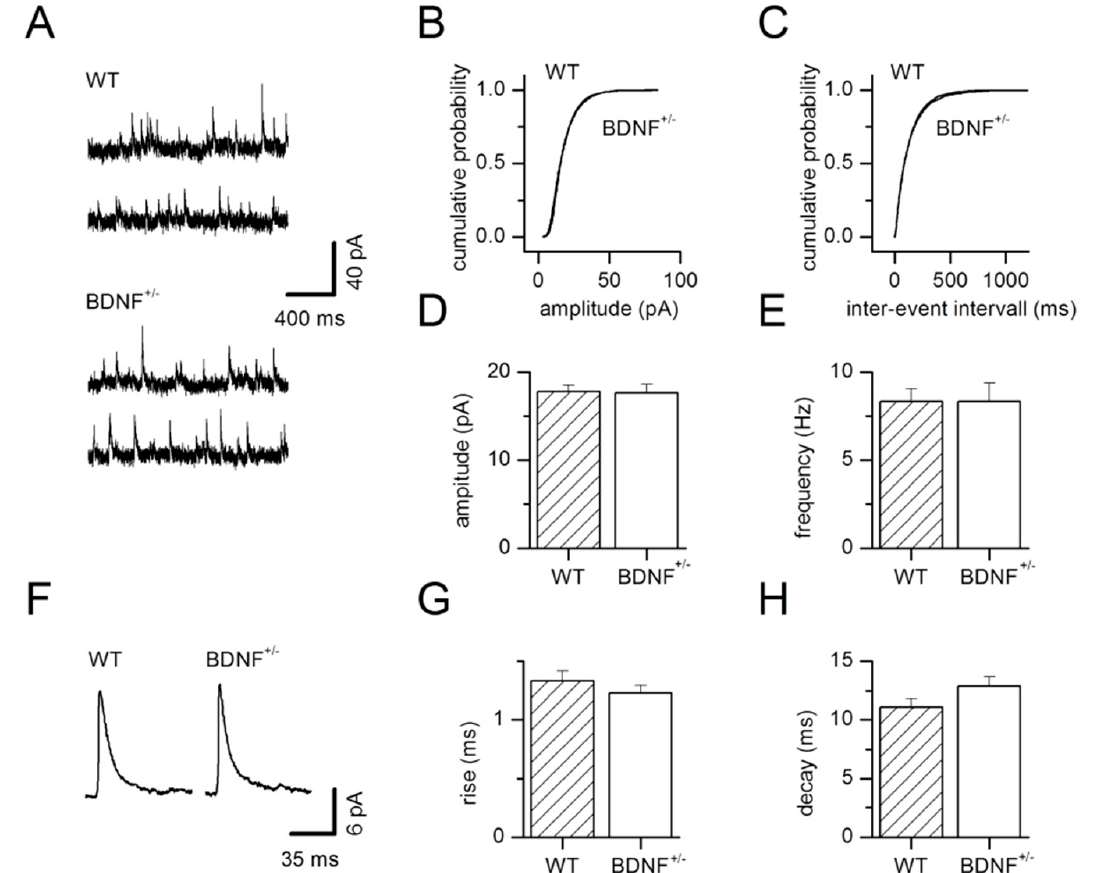
Figure 2. Properties of miniature GABAergic IPSCs (mIPSCs) in BDNF +/ − and WT mice. ( A ) Repre- sentative examples of mIPSCs recorded in LA projection neurons of WT and BDNF +/ − mice. ( B ) Cu- mulative amplitude and ( C ) inter-event interval histograms obtained from WT and BDNF +/ − neurons, with 300 events analyzed for each individual cell. Mean mIPSC amplitude ( D ) and frequency ( E ) pooled for WT and BDNF +/ − neurons. Note the unaltered amplitude ( B,D ) and frequency ( C,E ) of mIPSCs in BDNF +/ − mice compared to WT littermates. ( F ) Typical examples of averaged mIPSCs for a representative WT or BDNF +/– neuron, respectively. Neither rise time ( G ) nor decay time constant τ ( H ) of mIPSCs differed between genotypes. WT: n = 10 neurons from 10 animals, BDNF +/ − : n = 8